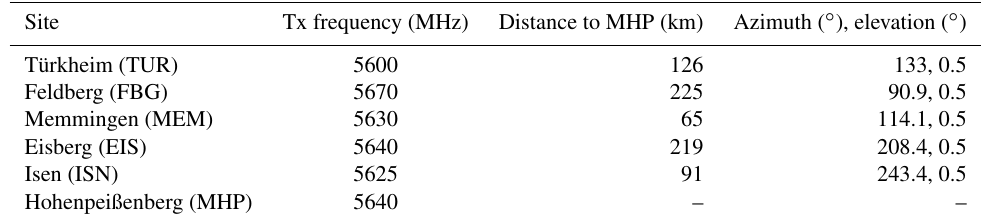
Table 1. A summary of operational radar sites used in the interference test. Azimuth ( ◦ ) and elevation ( ◦ ) describe the angle configuration of the pointing scan towards MHP.